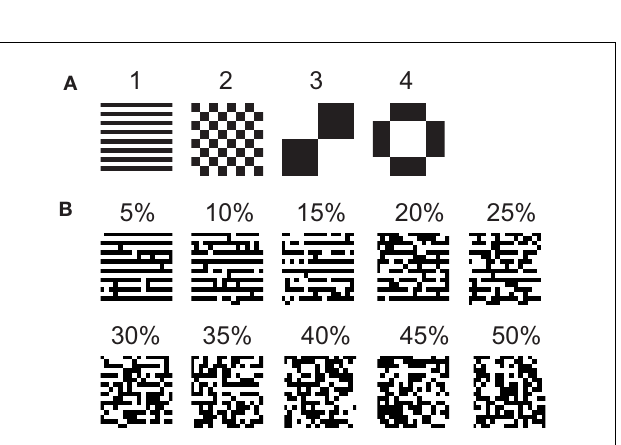
− N + 3 ) th clock, just after the stage in the DSSN unit runs at the ( Nf × N 2 v FIGURE 6 | Clock cycles for an update step of our network. The v 4 horizontal axis is the clock cycle. Each square labeled with a number calculation of I stim of the first neuron.The second and the third stages run corresponds to one clock. Each row represents a logic unit utilized in a with 1 clock and 2 clocks delay after it. In the silicon synapse unit, the first SNNM.The logic units, 4 adders and 4 multipliers which belong to the stage starts running after the membrane potential v of the first neuron is + 1 clocks because ( N × N − 1 ) × N accumulator unit cost Nf × N 2 v obtained in the DSSN unit. So all of the logic units finish their calculation at f v v addition 4 + 6 ) th clock. the ( Nf × N 2 v and N f × N 2 multiplication are required in an accumulator unit.The first v 4